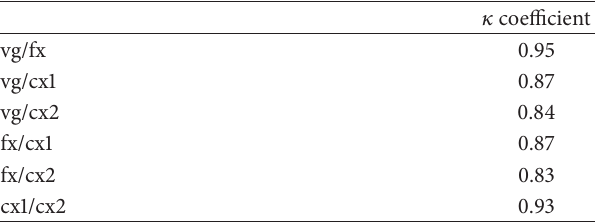
Table 2: Qualitative reproducibility during first trimester.